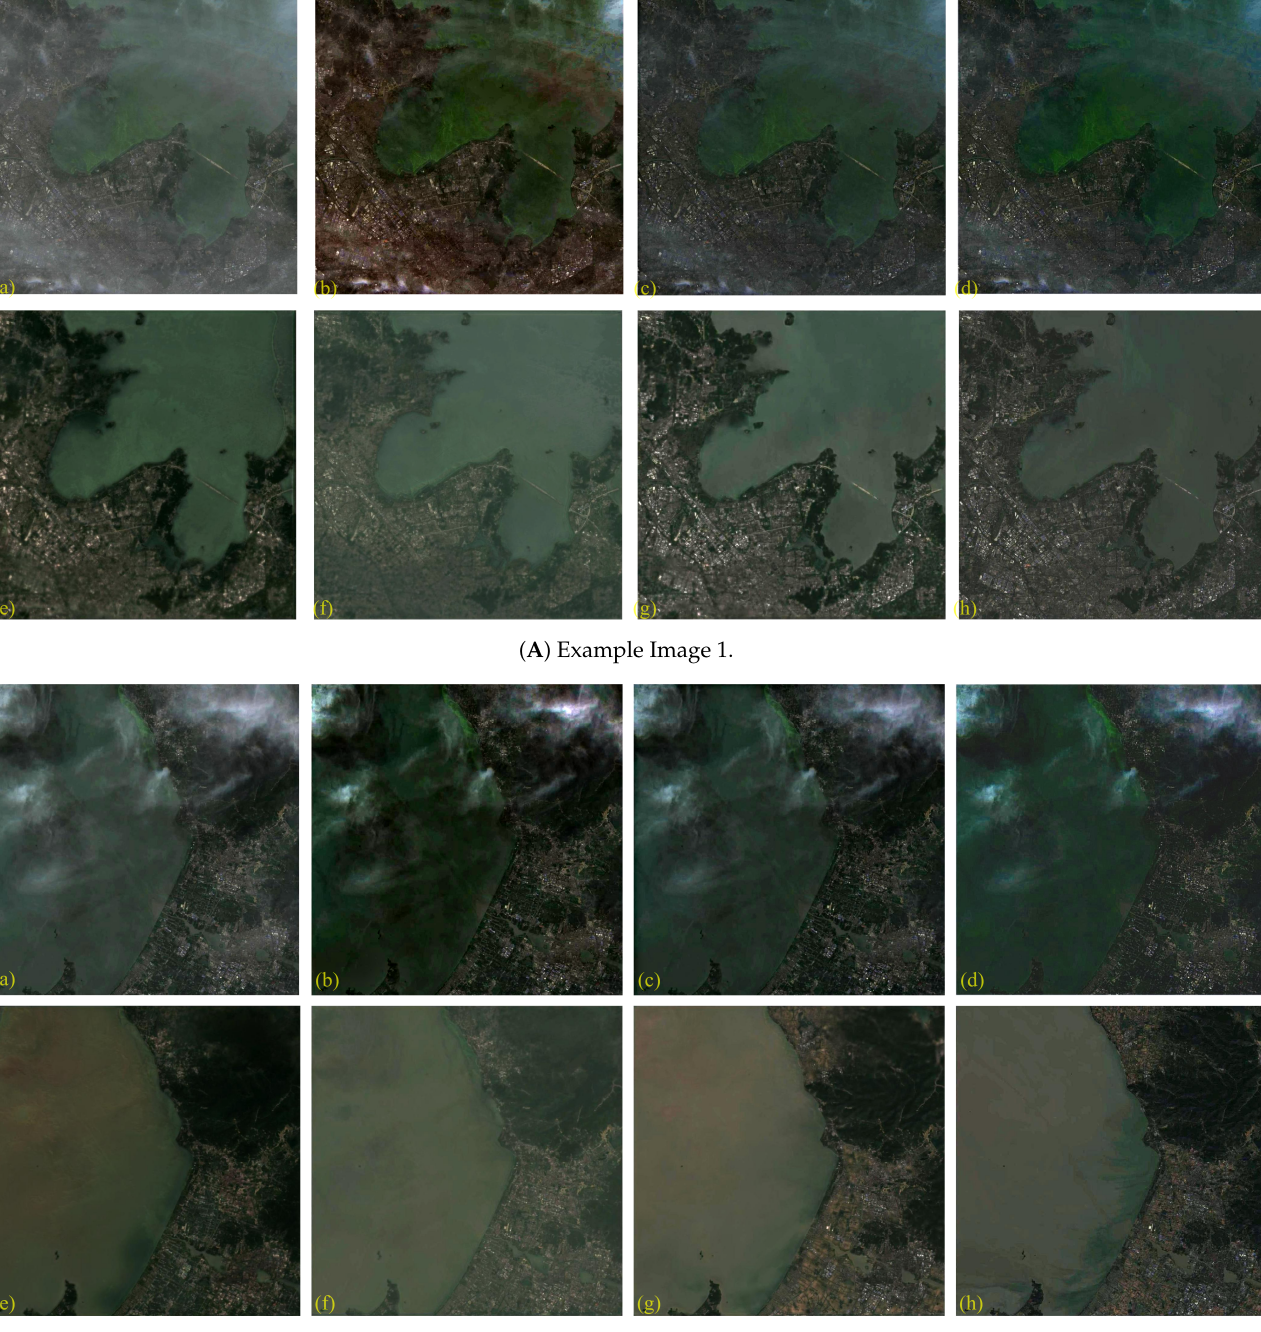
Figure 10. Dehazing results on images with moderate haze interference. ( a ) Hazy image; ( b ) DCP; ( c ) DehazeNet; ( d ) AOD-NET; ( e ) GridDehazeNet; ( f ) MSBDN; ( g ) proposed method; ( h ) haze- free